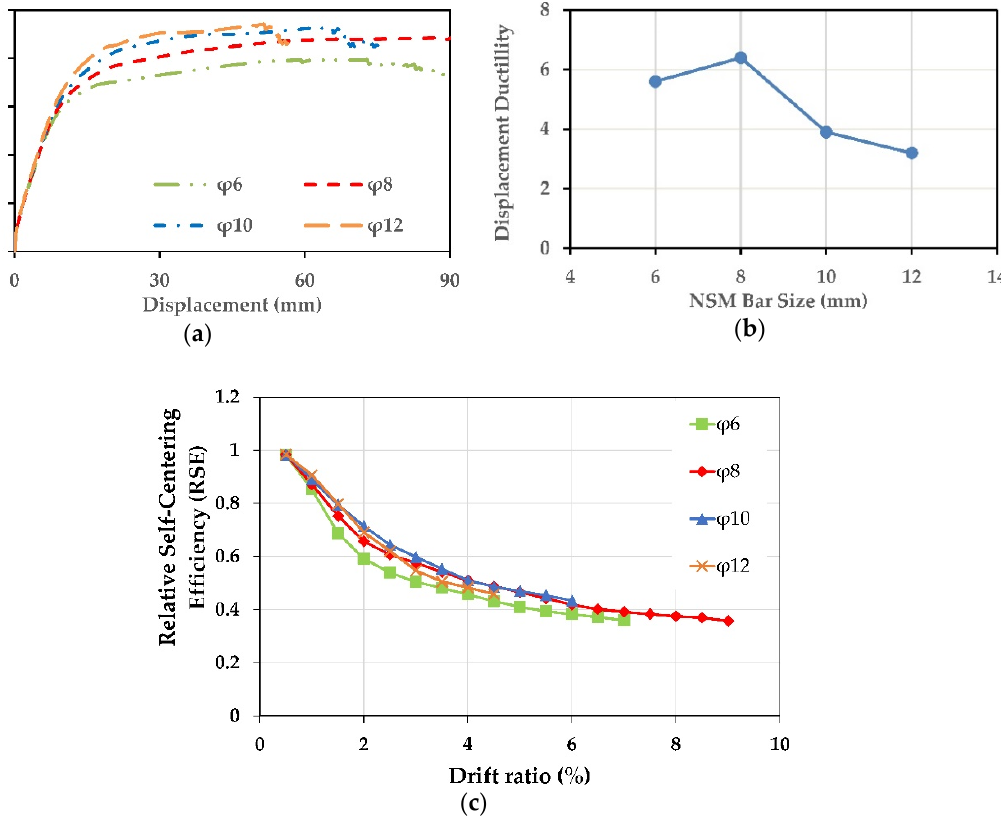
Figure 18. Effect of NSM-SMA bar size on the column C-C-SMA2: ( a ) Pushover curves; ( b ) Figure 18. E ff ect of NSM-SMA bar size on the column C-C-SMA2: ( a ) Pushover curves; ( b ) displacement displacement ductility; ( c ) Relative Self Centering Efficiency. ductility; ( c ) Relative Self Centering E ffi